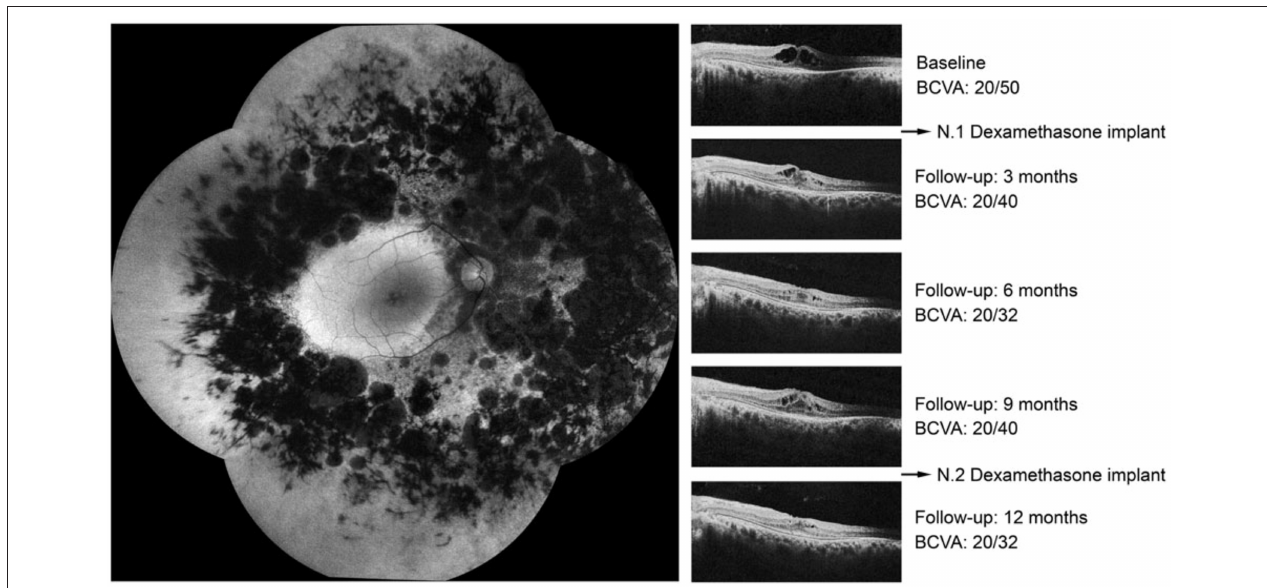
FIGURE 7 | Autofluorescence and optical coherence tomography (OCT) images of a 41-year-old woman affected by macular edema after retinitis pigmentosa (RP) and treated with 1 injection of dexamethasone implant at baseline and at month 9. At baseline, BCVA (Snellen equivalent) was 20/50, and the presence of intraretinal fluid was detected by OCT. At months 3 and 6, BCVA improved, and a reduction in CRT was observed. At month 9, a gradual visual loss and an increase of intraretinal fluid were noted. An additional intravitreal dexamethasone implant was performed at month 9. At 12 months, BCVA improved to 20/32, and no fluid was detected by OCT. This figure was reproduced from Veritti et al. (14). The publisher for this copyrighted material is Mary Ann Liebert, Inc.